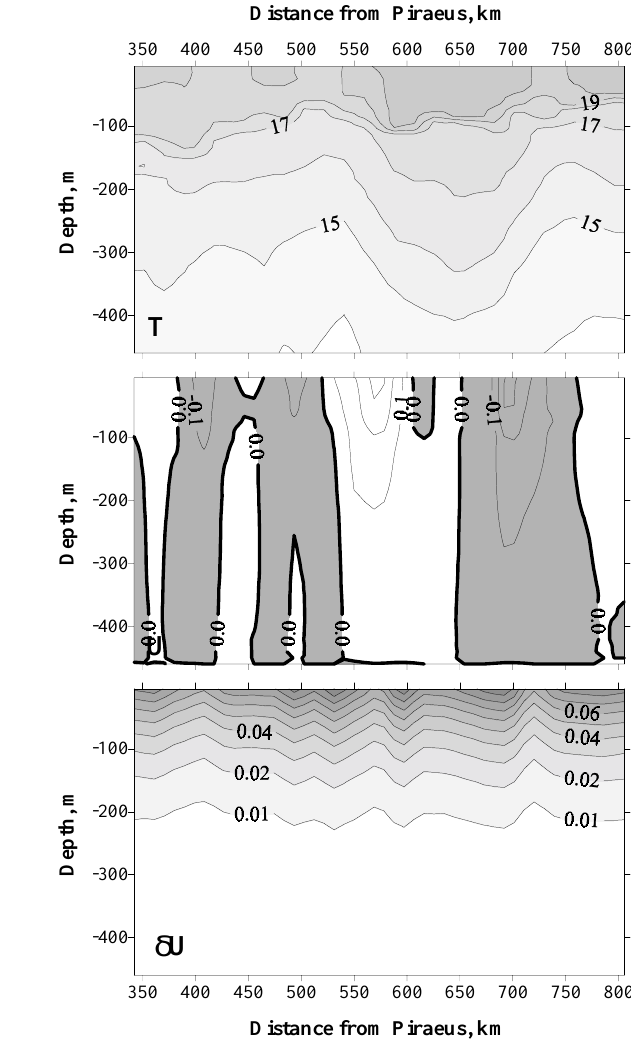
Fig. 7a. Contours of temperature (top), cross-track geostrophic ve- locity U (m/s) relative to 460m (center) and possible salt-induced velocity error δU (bottom), along the transect from Cretan Straits to Alexandria selected crossings. In the central panel, the shaded (clear) regions denote velocity towards the southwest (northeast).